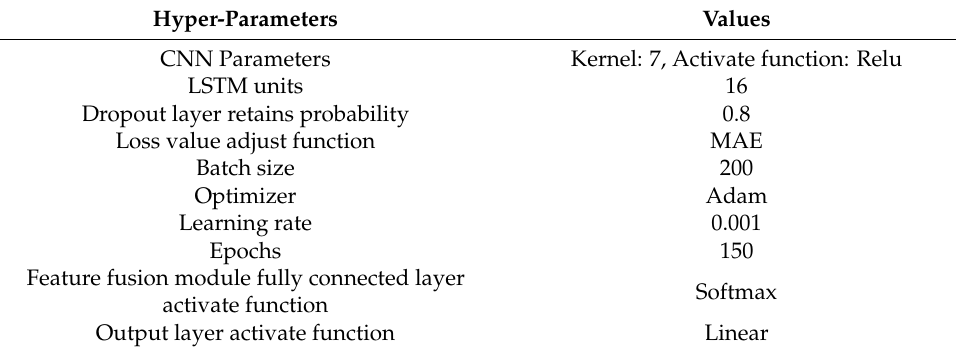
Figure 9. Optimizer selection and model training loss performance. ( a ) Comparison of forecasting errors of different optimizers. ( b ) Loss curves and model training validation prediction accuracy curves for each load. Table 2. MFFCLA model hyper-parameter selection.